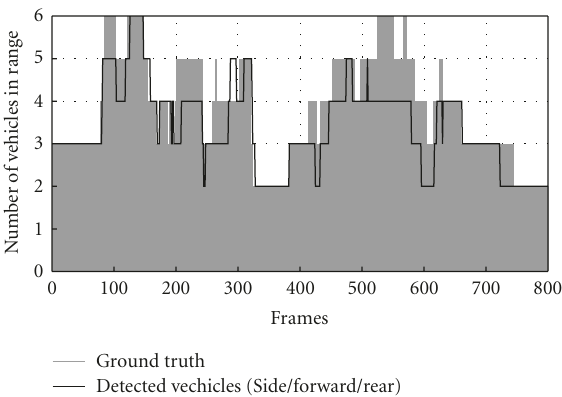
Figure 16: Number of vehicles detected by the three vision modules compared with the manually labeled ground truth in a real sequence.